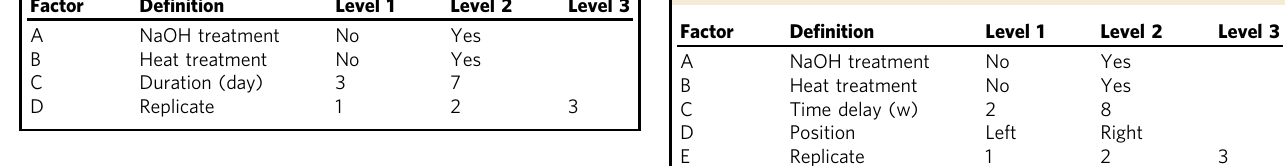
Table 2 Statistical design of experiments used in both torque tests as well as histology study. In each study, 48 implants are